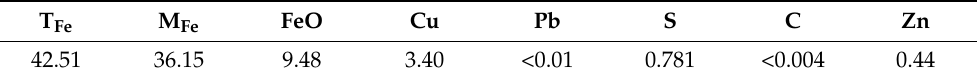
Table 2. The chemical composition of copper slag after reduction under suitable conditions (wt. %).